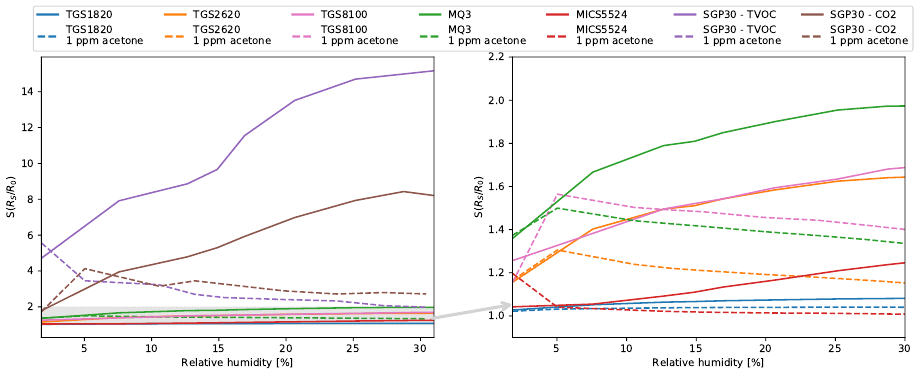
Figure 9. Sensors’ sensitivity in different relative humidities in chamber.